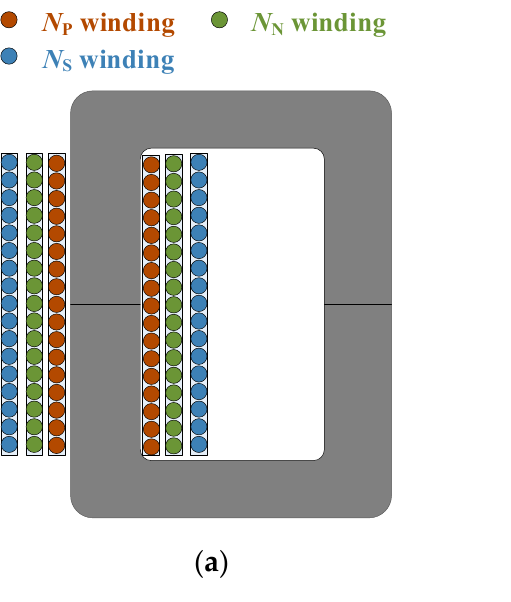
Figure 3. Winding arrangement: ( a ) layered structure; ( b ) stacked structure.